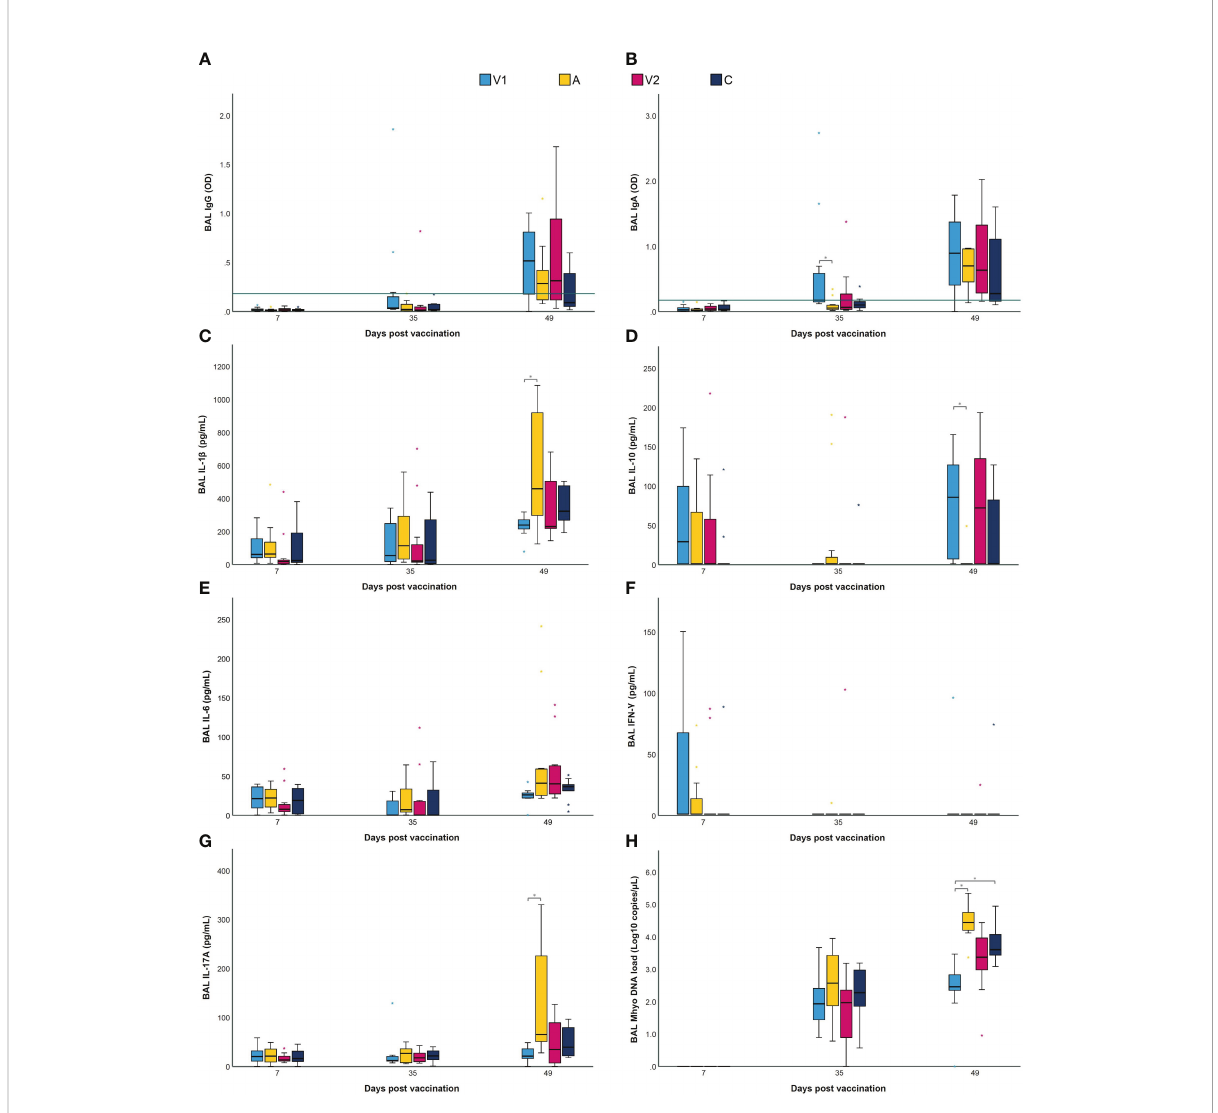
FIGURE 3 BAL IgG and IgA, cytokines and M. hyopneumoniae DNA load following vaccination and challenge infection. Piglets were vaccinated on D0 with V1, A, V2 or physiological saline solution (C), and animals were challenge infected on D21 and euthanized on D49. Mycoplasma hyopneumoniae -speci fi c IgG (A) and IgA (B) levels were detected in BAL using an indirect ELISA, with values expressed as optical density (OD). For M. hyopneumoniae -speci fi c IgG and IgA, BAL samples were considered as positive if they had an average OD value higher than the